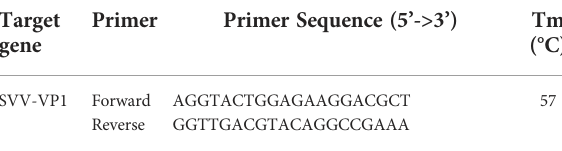
TABLE 1 Primer sequencesof genesselectedfor